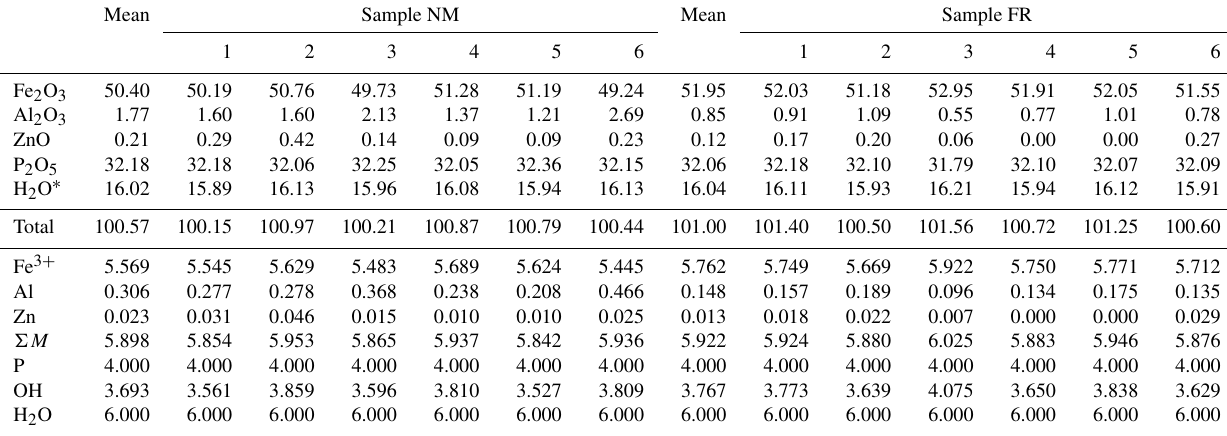
Table 1. Chemical composition of beraunite from Hrbek. Mean